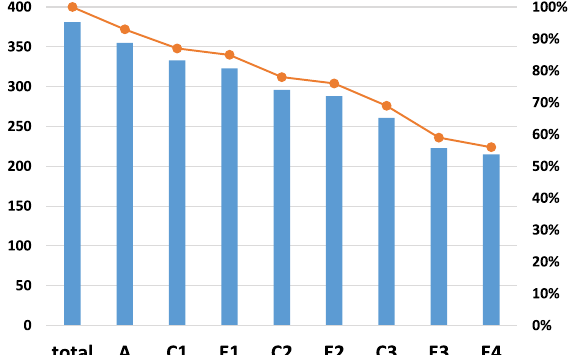
FIG. 4. The correctness of each step as students progressed through the time evolution problem. In the diagram, the histo- gram denotes the number of correct solutions, and the dots label the correct percentage with respect to the total